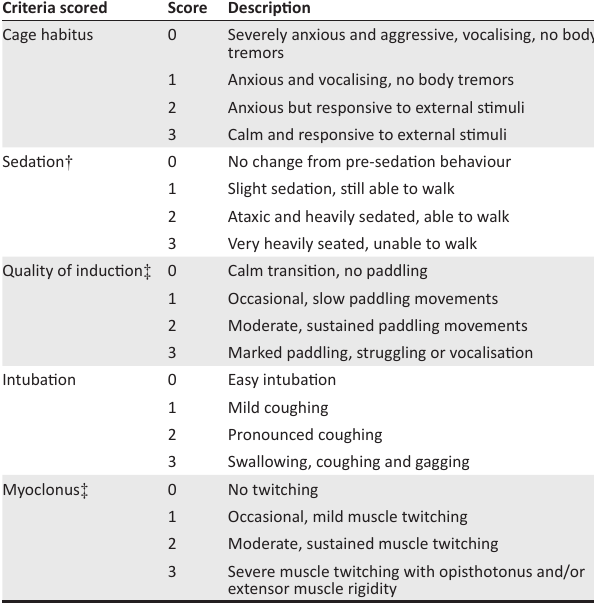
TABLE 1: Simple descriptive scale for scoring habitus during cage rest, sedation following premedication (acepromazine 0.02 mg/kg and morphine 0.3 mg/kg) intramuscularly and quality of intravenous induction, intubation and incidence of myoclonus,with either propofol or diazepam-ketamine in male dogs. Criteria